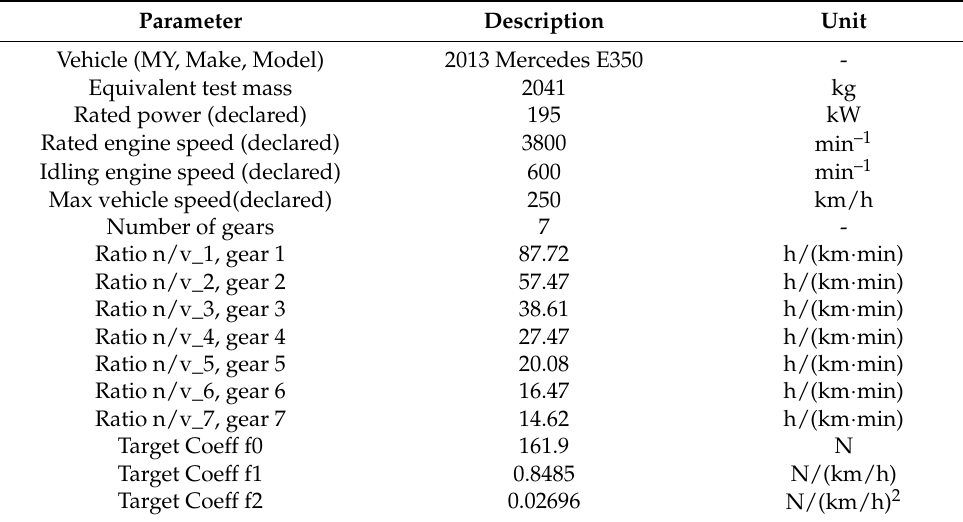
Table 3. Parameters of the vehicle used in the tests for drive